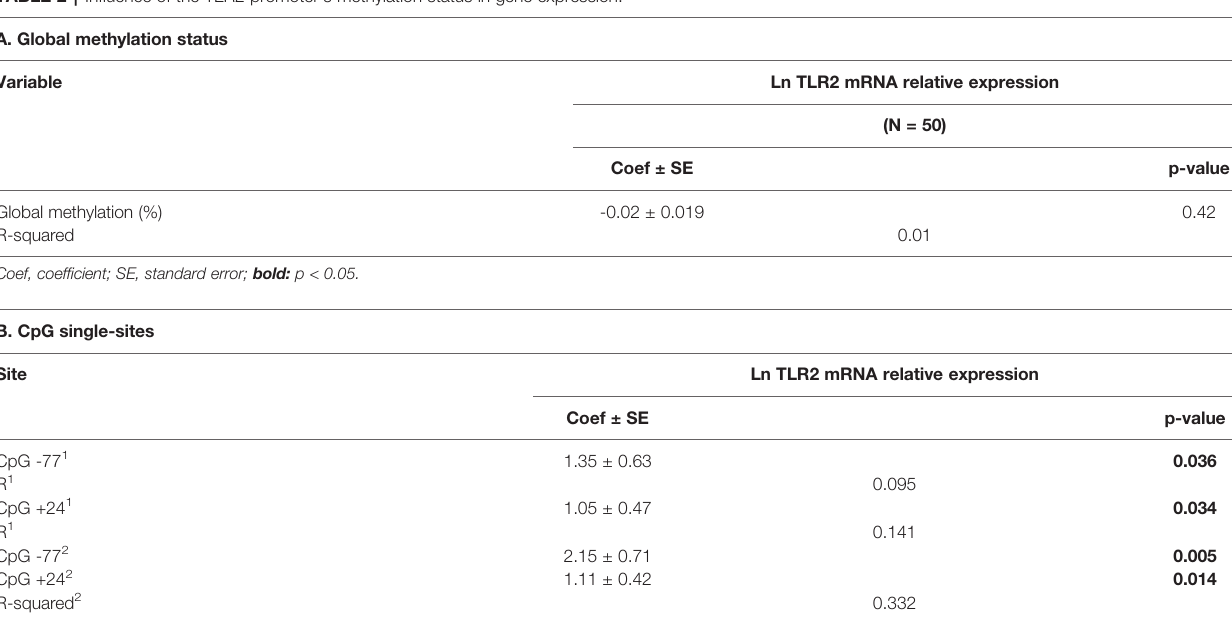
TABLE 2 | In fl uence of the TLR2 promoter ’ s methylation status in gene